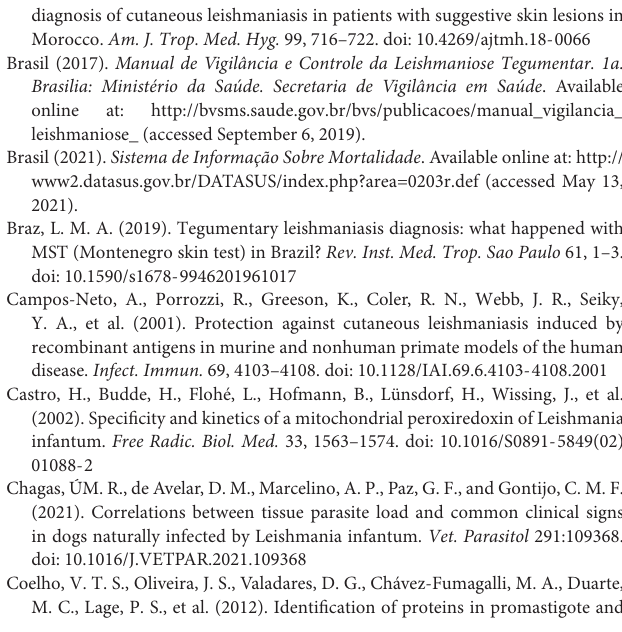
Supplementary Figure 2 | Sequences of mTXNPx: (A) amino acid sequence of L. infantum mTXNPx (PDB ID: 6E0F) containing 226aa. (B) Synthetic gene construction containing the DNA sequence (678 bp), restriction enzyme sites Bam HI and Hin dIII at the 5 (cid:48) and 3 (cid:48) ends, respectively, and the stop codon. Supplementary Figure 3 | Production of recombinant mTXNPx. (A) Polyacrylamide gel with DNA fragment of synthetic gene stained with silver, (B) 15% SDS-PAGE with lysate of culture before (1) and after (2) induction with IPTG and purified recombinant mTXNPx (3). (C) Western blotting using monoclonal 6x-His-tag antibody against recombinant mTXNPx. Molecular marker: 100 bp DNA Ladder (Promega, United States); molecular weight markers: Amersham ECL Rainbow Markers (GE Healthcare, Chicago, IL, United States). Supplementary Figure 4 | Production of anti-mTXNPx monoclonal antibody. (A) Kinetics of antibody production (pools of sera) measured by ELISA before each immunization from mice immunized with recombinant mTXNPx or saline plus Freund’s adjuvant. (B) 15% SDS-PAGE showing purified monoclonal anti-mTXNPx antibody under denaturing conditions (fragments of ∼ 50 and ∼ 25 kDa corresponding to heavy and light chains,